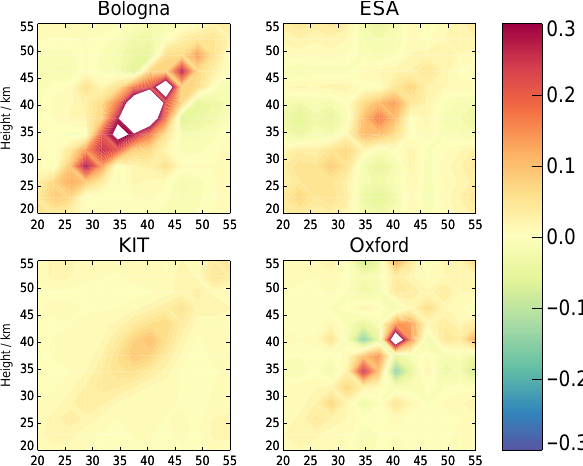
Figure 2. Statistical covariance matrices of four parent MIPAS pro- cessors. The white areas in Bologna and Oxford plots are for values bigger than 0.3: up to 0.82 for Bologna and up to 0.44 for Oxford processors.